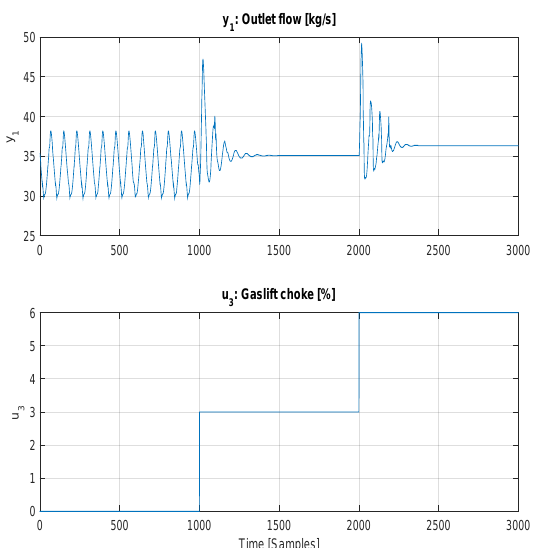
Figure 5: Open-loop simulations in K-Spice. Introduc- ing the Gaslift choke at Time = 1000 Sam- ples.